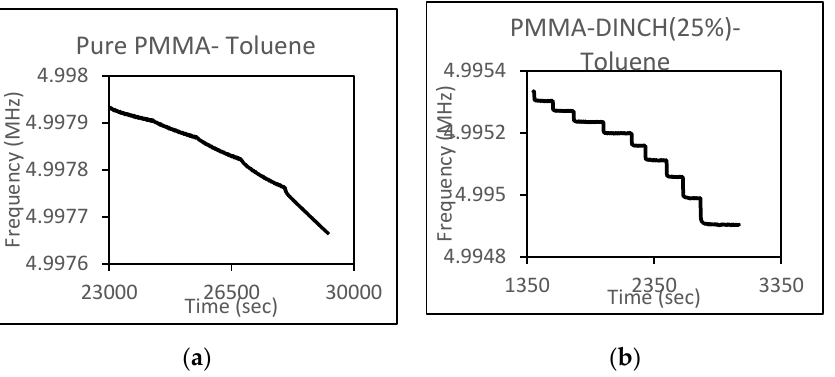
Figure 2. Frequency–time curves for pure PMMA-toluene ( a ) and a DINCH-plasticized PMMA